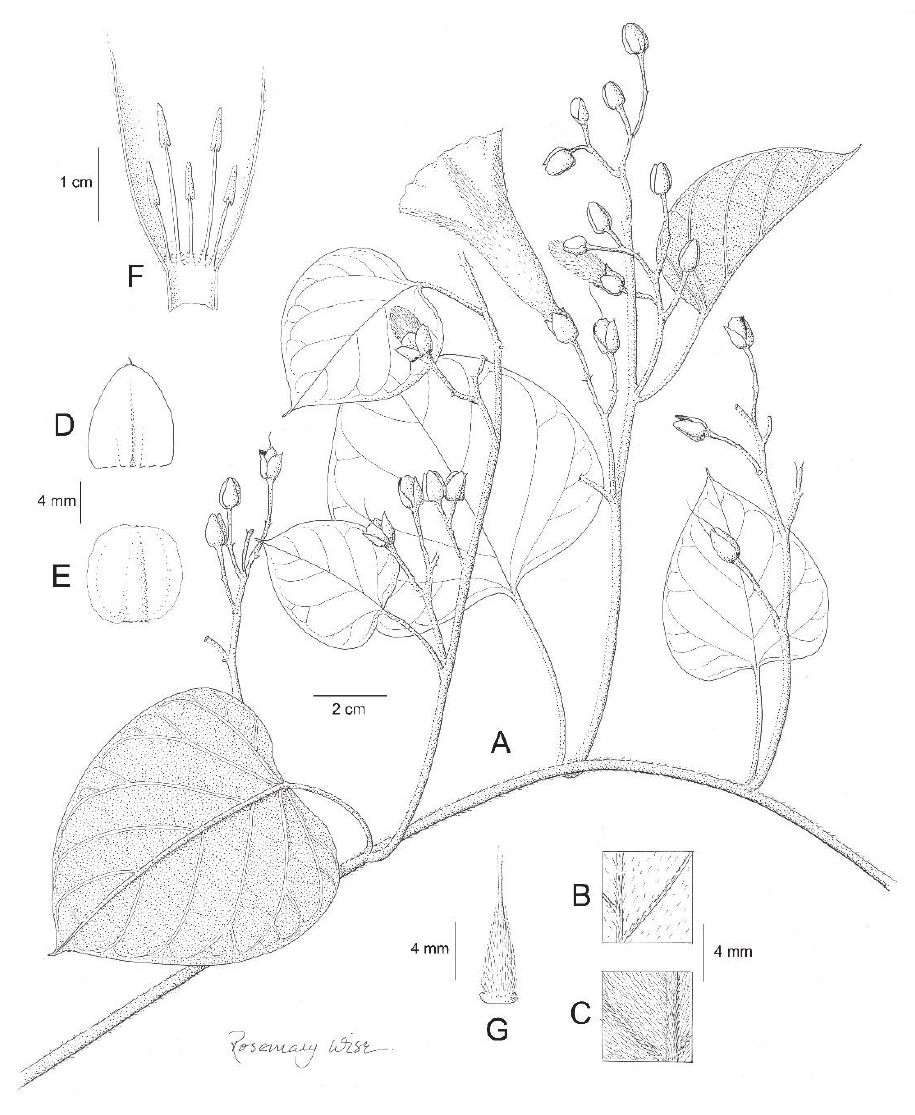
Figure 18. Ipomoea velutinifolia. A habit B adaxial leaf surface C abaxial leaf surface D outer sepal e inner sepal F corolla opened out to show stamens G ovary. Drawn by Rosemary Wise from E.L. Taylor, et al. 1326.